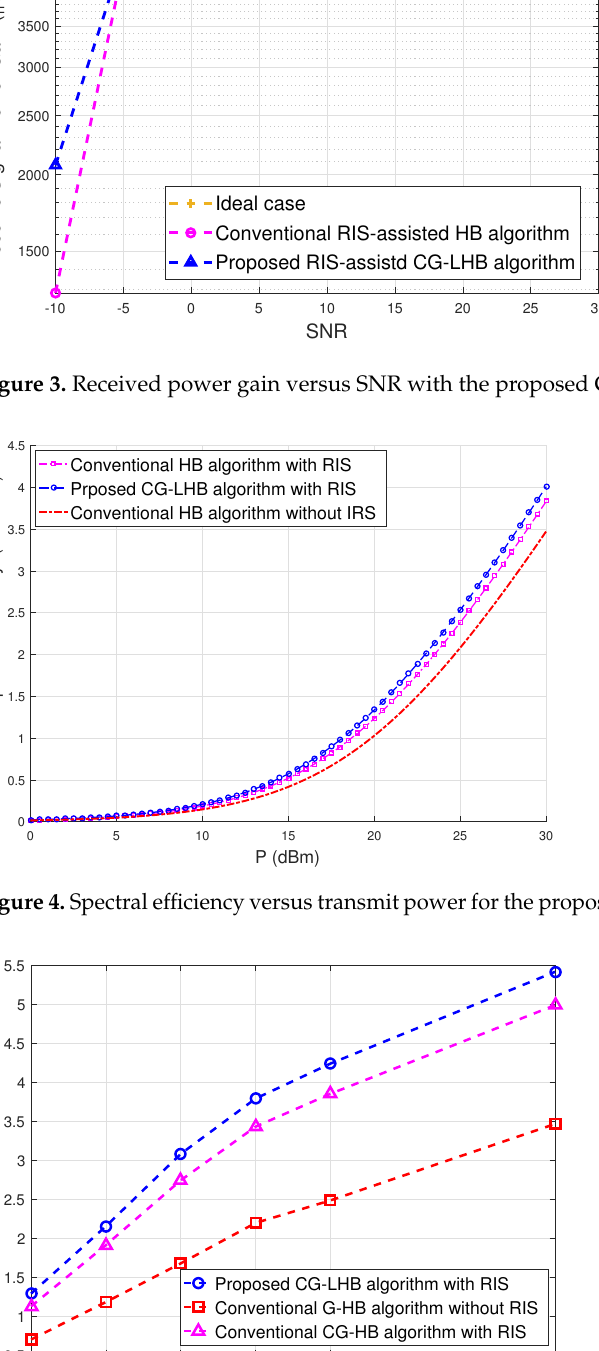
Proposed CG-LHB algorithm with RIS Conventional G-HB algorithm without RIS Conventional CG-HB algorithm with RIS